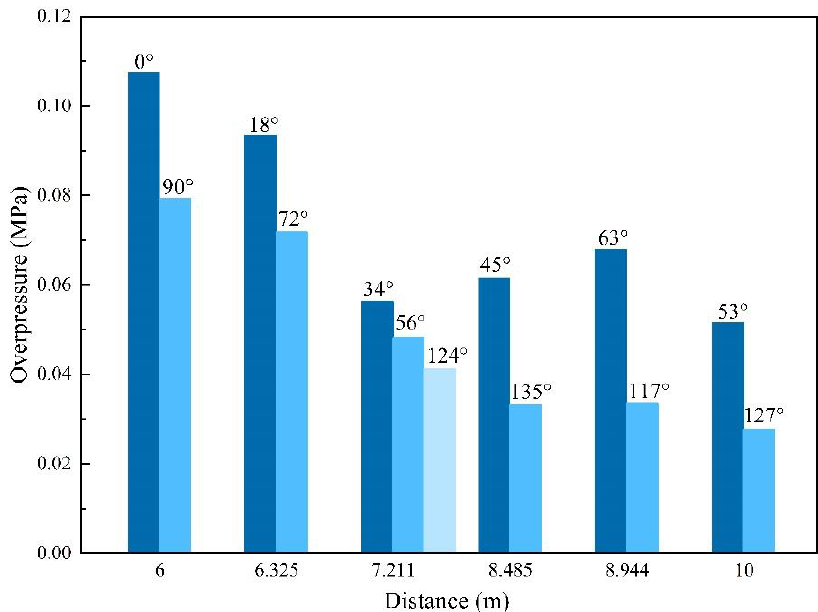
Figure 8. Overpressure values of different directions in the moving charge explosion with a charge speed of 580 m/s.